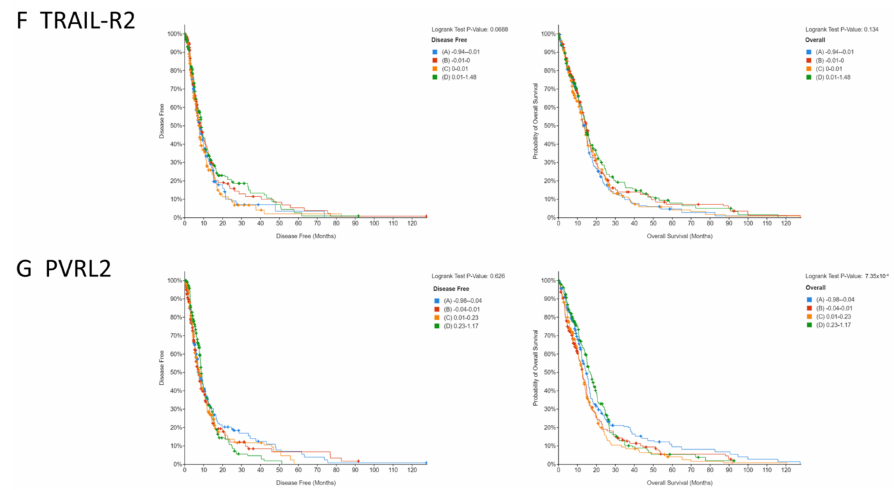
Figure 1. Low copy number of genes encoding NK cell-activating receptor ligands and death receptors is associated with a poorer survival in GBM. Kaplan–Meier’s graphs showing the association between capped relative linear copy number values and (left) disease-free survival and (right) overall survival and expression of ( A ) ULBP3, ( B ) NCR3LG1, ( C ) MICA, ( D ) MICB, ( E ) FAS, ( F ) TRAIL-R2, and ( G ) PVRL2. Patients with available data were divided into quartiles based on their capped relative linear copy number values and assessed for significance using a Logrank